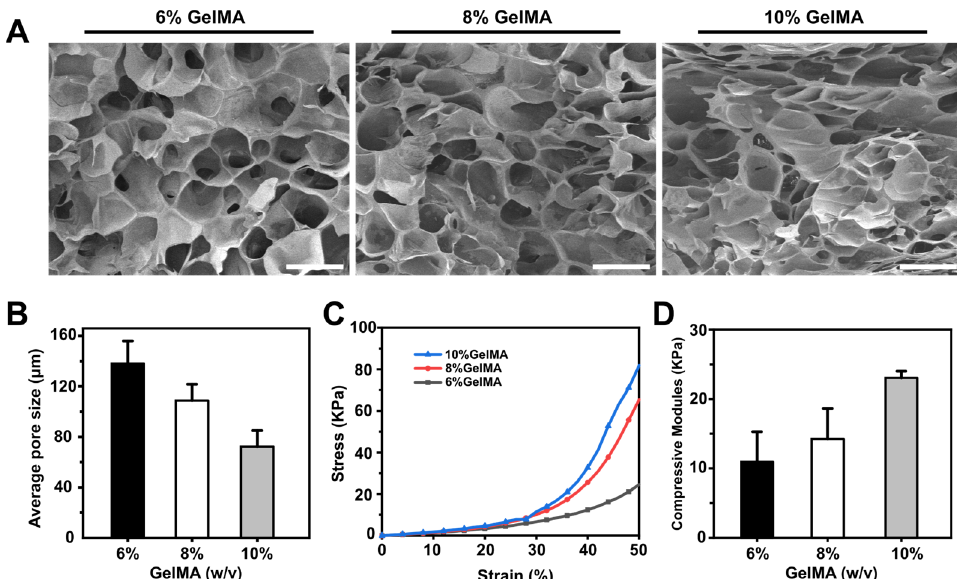
Figure 2. ( A ) Morphology characterization of GelMA hydrogels with concentrations of 6%, 8%, and 10% by SEM. Scale bar: 200 µ m. ( B ) Quantitative analysis of the average pore size in the GelMA hydrogel of 6%, 8%, 10% concentrations. ( C ) Compressive stress–strain curves of GelMA hydrogels at different concentrations. ( D ) Compression modulus of hydrogels at three different concentrations of 6%, 8%,